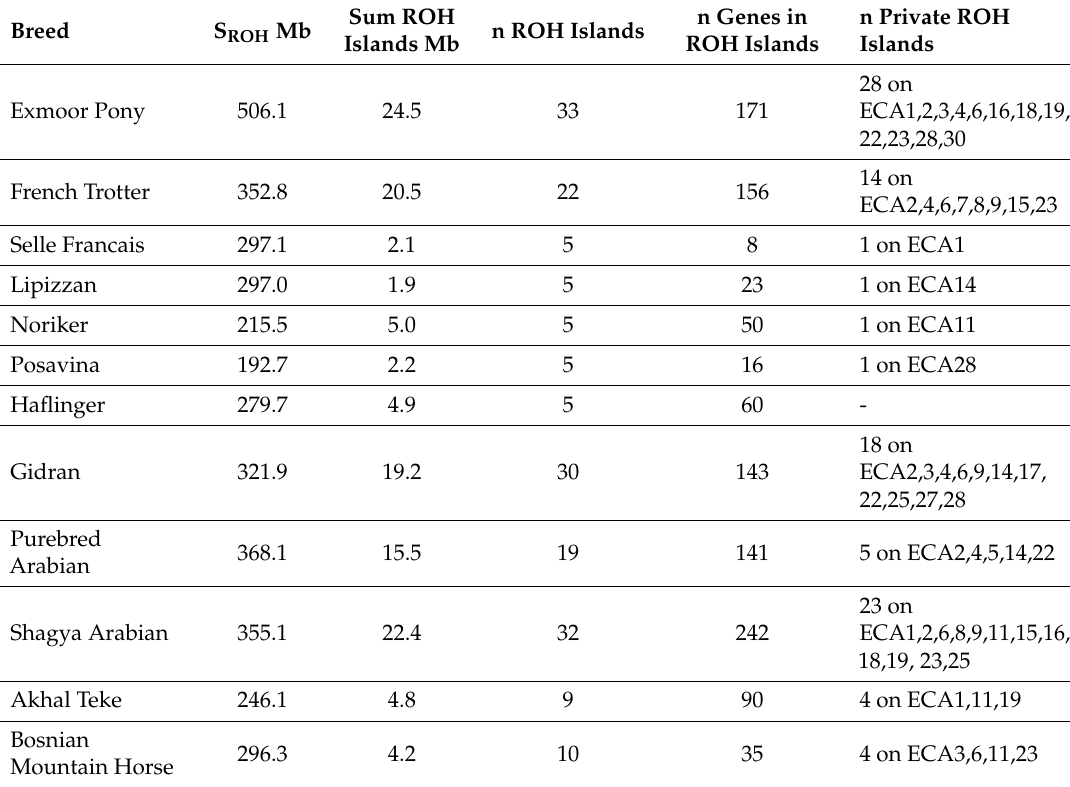
Table 2. Mean genome length covered by runs of homozygosity S ROH values (in Mb), total length of overlapping homozygous regions (ROH islands) (in Mb), number of ROH islands and number of annotated genes within ROH islands per breed and number of private ROH islands per